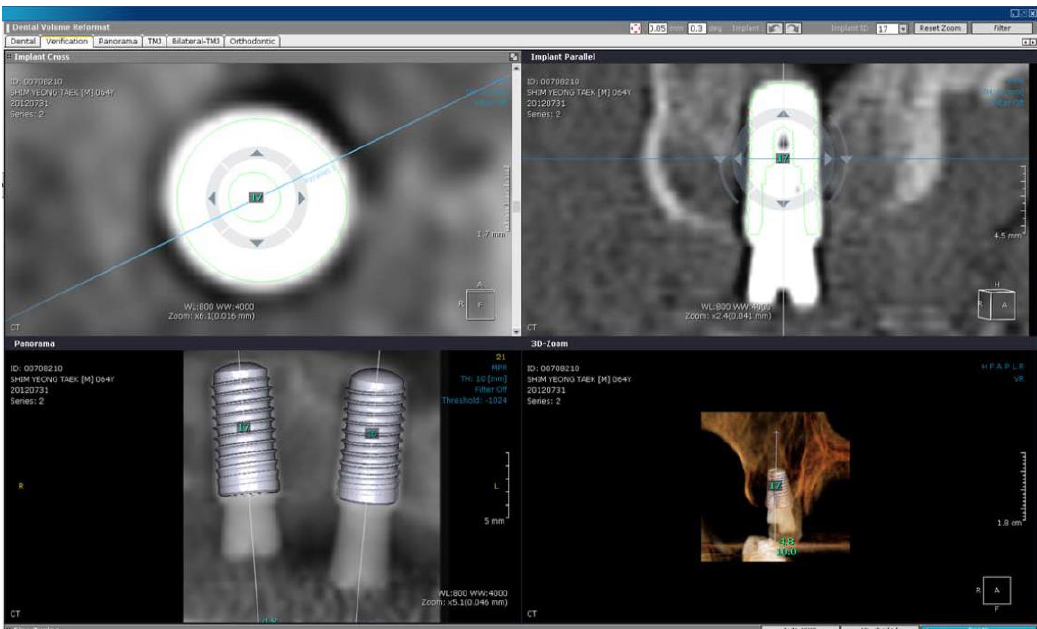
Figure 1. Axial, cross-sectional, panoramic, and 3-dimensional views after positioning of the implant model.